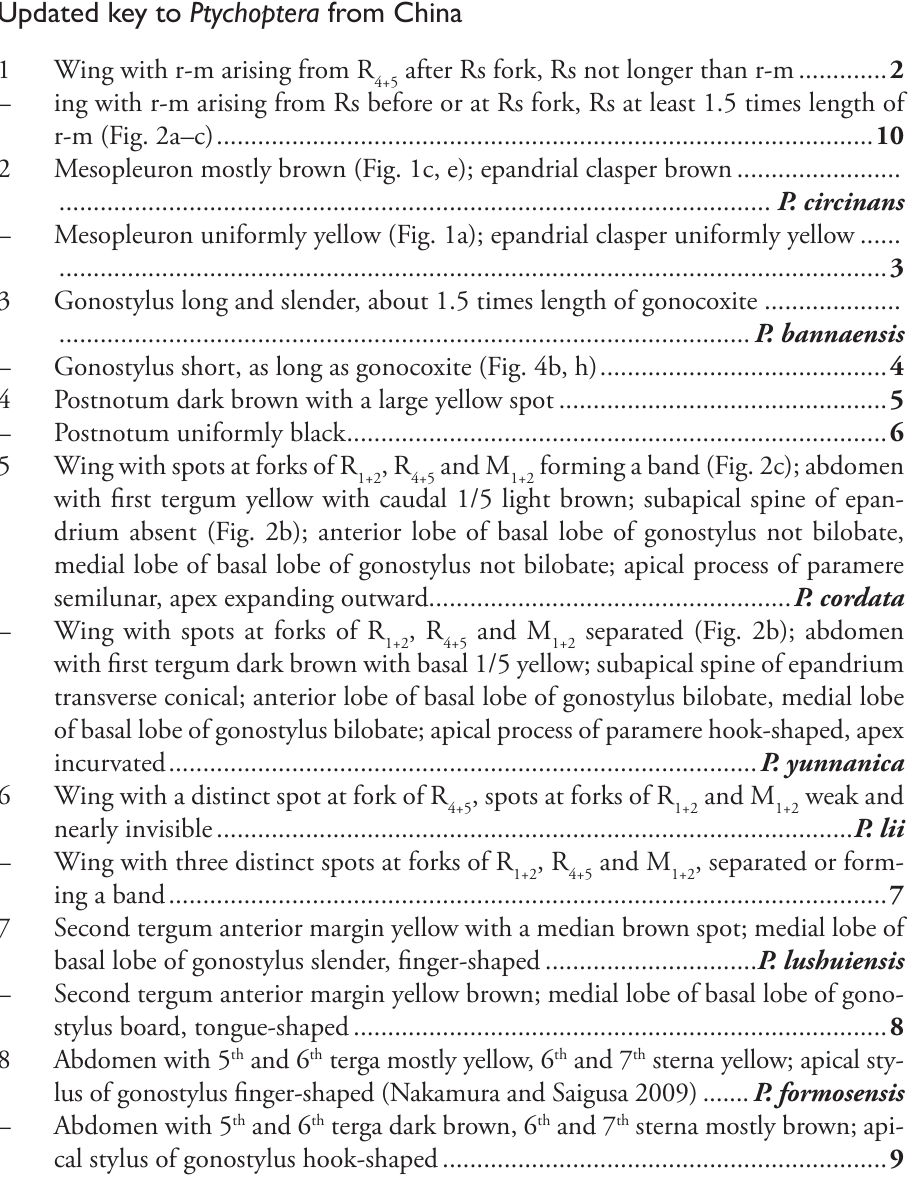
, R and M forming a band (Fig. 2c); abdomen 1+2 4+5 1+2 , R and M separated (Fig. 2b); abdomen 1+2 4+5 1+2 , spots at forks of R and M weak and 4+5 1+2 1+2 , R and M , separated or form- 1+2 4+5 1+2